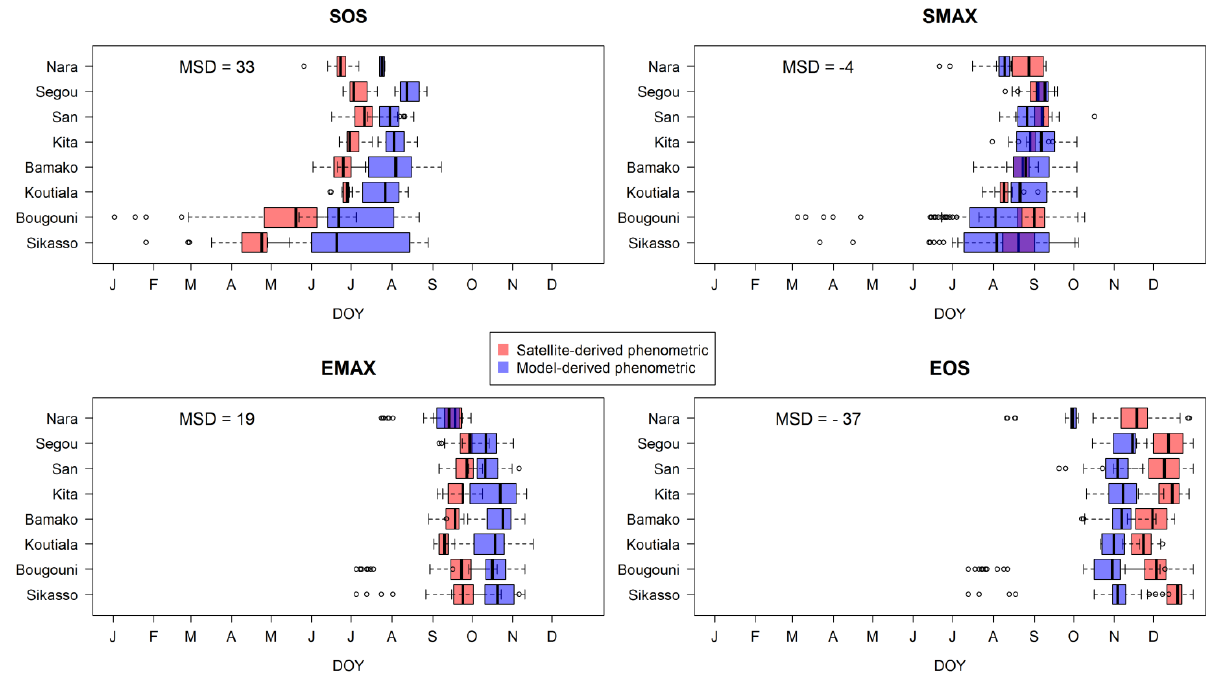
Figure 5. Satellite- (pink) and model-derived (violet) phenometrics boxplots were calculated for eight synoptic stations, ranged from north ( Top ) to south ( Bottom ), in 2007. The mean signed difference (MSD) is the difference between the model- and satellite-derived phenometric values in